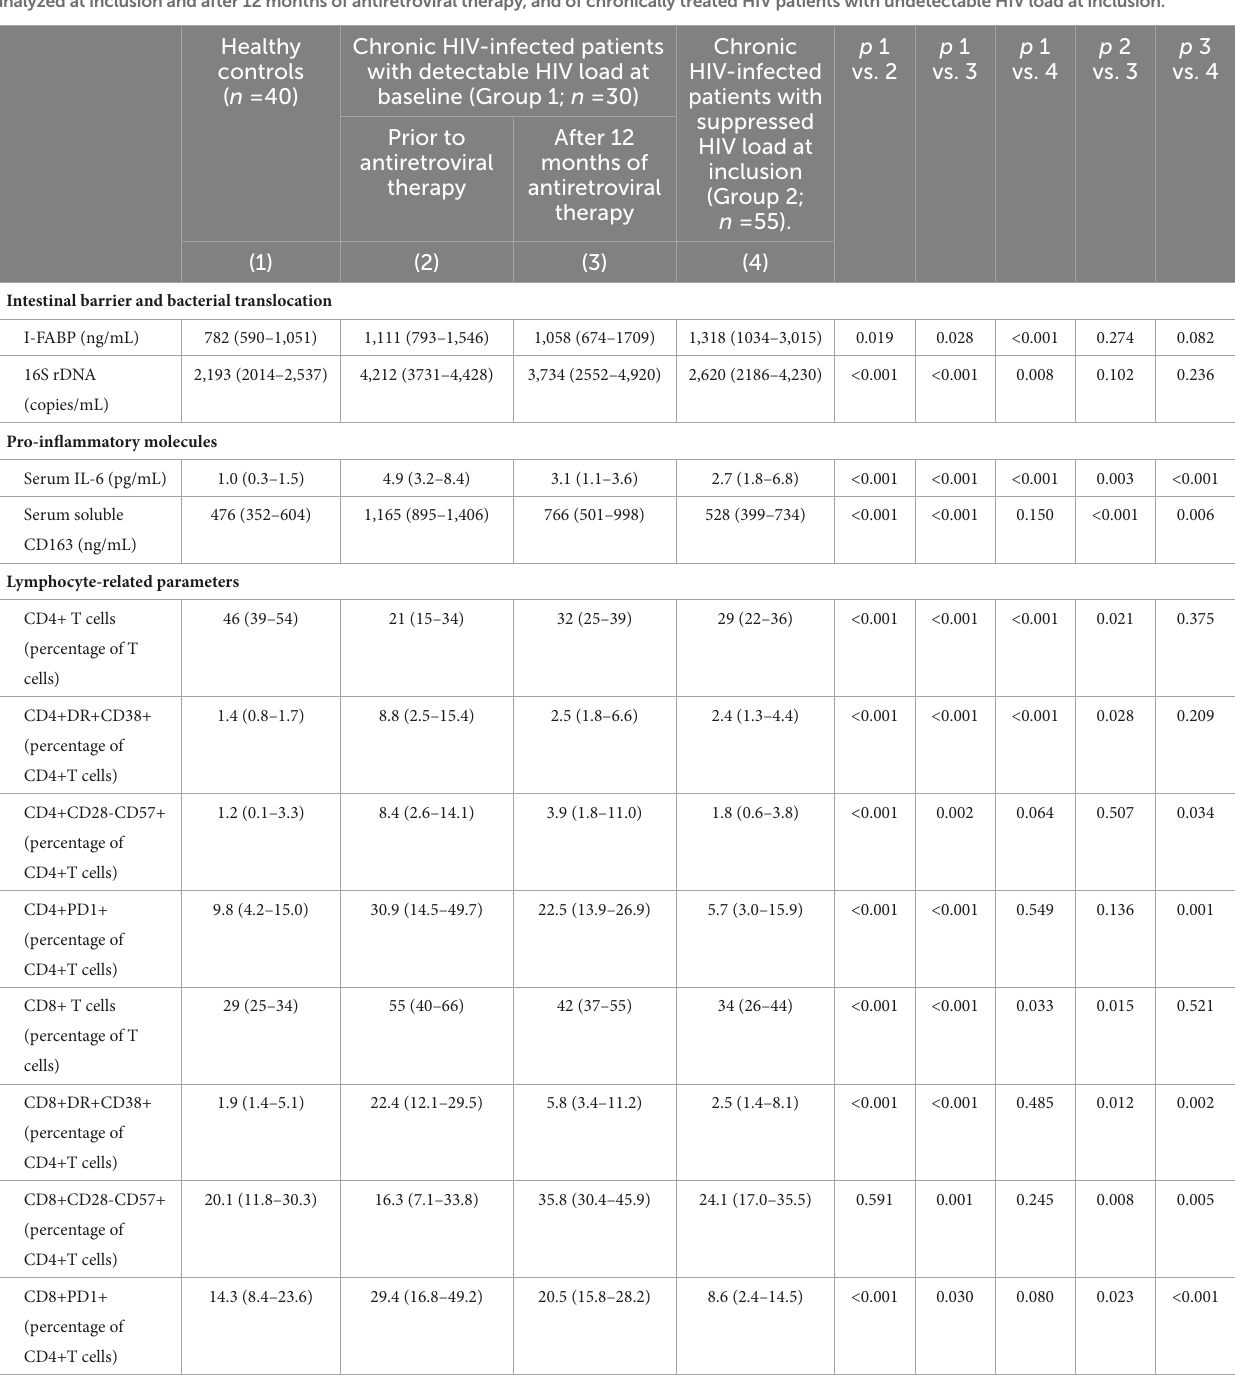
TABLE 2 Gut barrier status, bacterial translocation and immune characteristics of healthy controls and patients with HIV infection, untreated at baseline, analyzed at inclusion and after 12 months of antiretroviral therapy, and of chronically treated HIV patients with undetectable HIV load at inclusion. Healthy Chronic HIV-infected patients controls with detectable HIV load at ( n = 40) baseline (Group 1; n = 30)